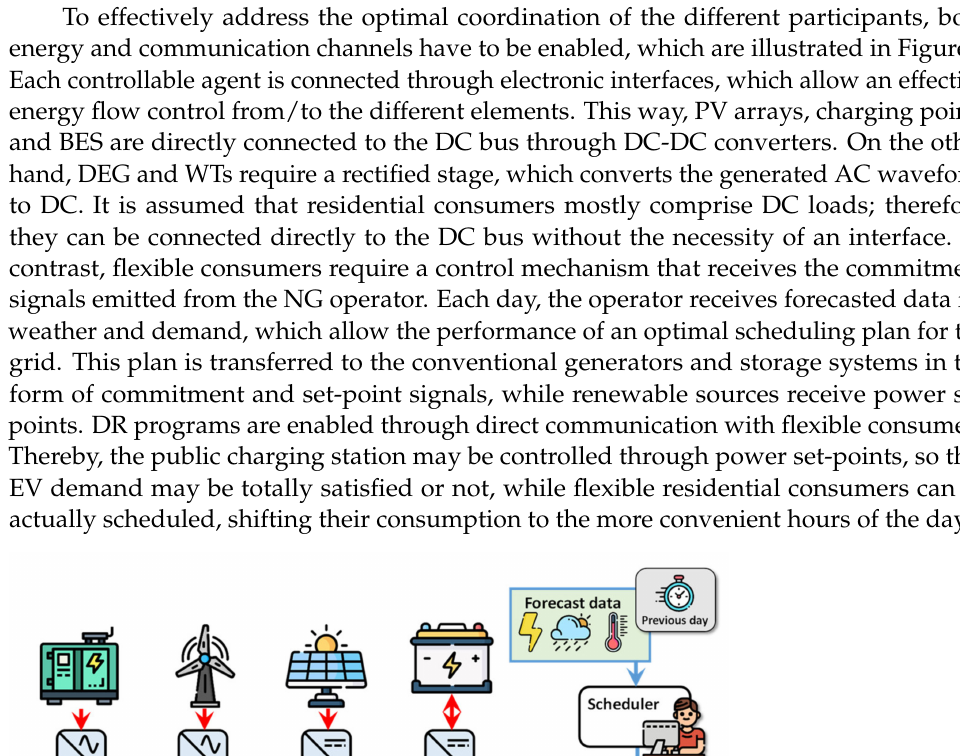
Figure 1. Pictorial representation of the agents involved in the operation of the NG under study and the more notable interactions among them.